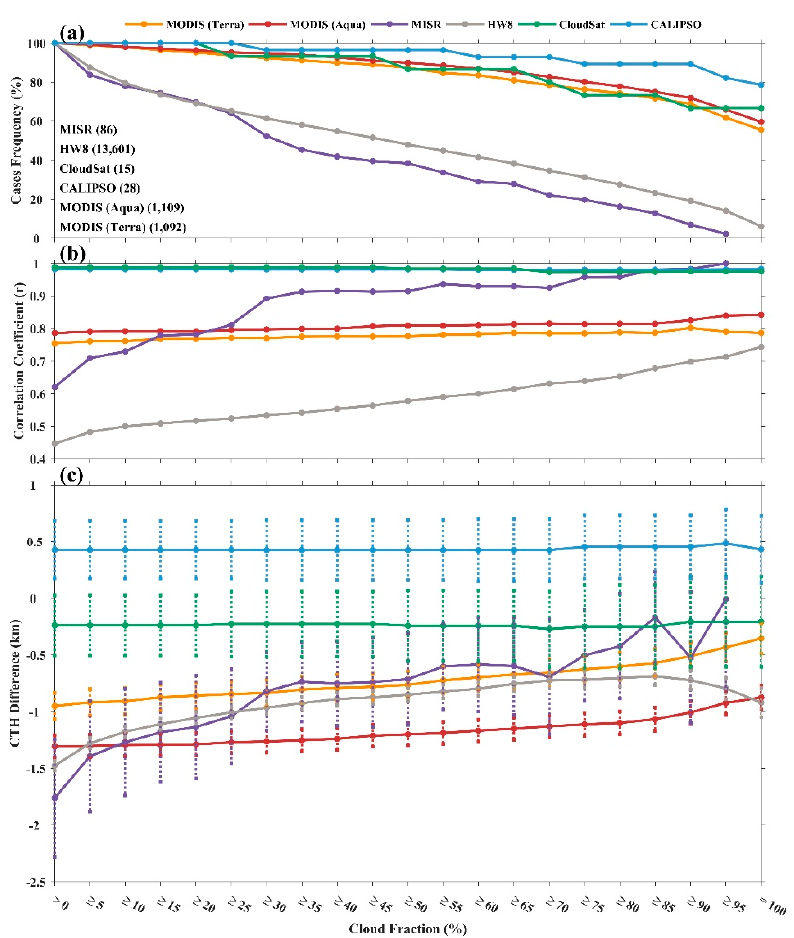
Figure 6. The line diagram of ( a ) the case frequency with cloud occurrence, ( b ) the correlation coefficient between satellite and KAZR, and ( c ) the mean CTH difference (the average of the difference that satellite CTH minus KAZR CTH for all cases), vary with KAZR cloud fraction greater than a certain threshold (i.e., an interval of 5% increases from 0% to 100%) for non-overlapping clouds. The number of initial cases marked in subplot ( a ) is the same as the number of cases in Figure 5, and the dotted line in subplot ( c ) represents the confidence interval of the mean difference at the 95% significance level.